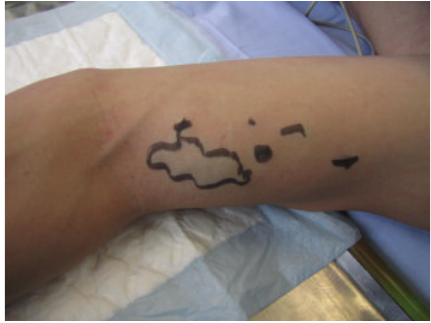
Figure 2: Multifocal location—preoperative finding.